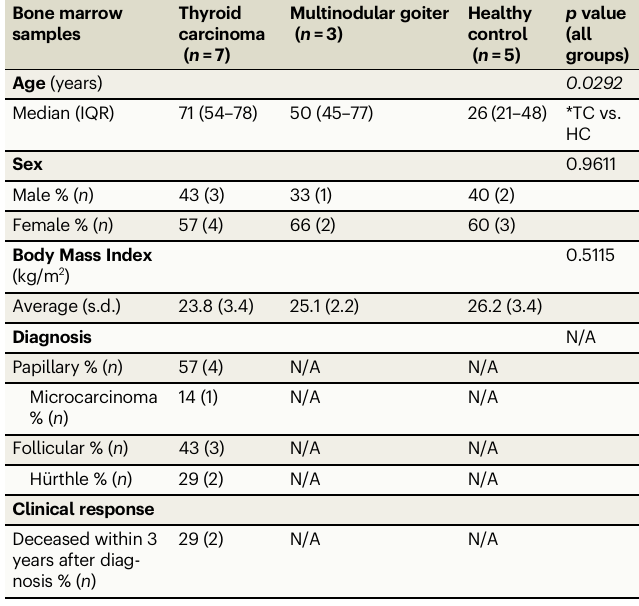
Table 2 | Baseline characteristics bone marrow samples Bone marrow Thyroid samples